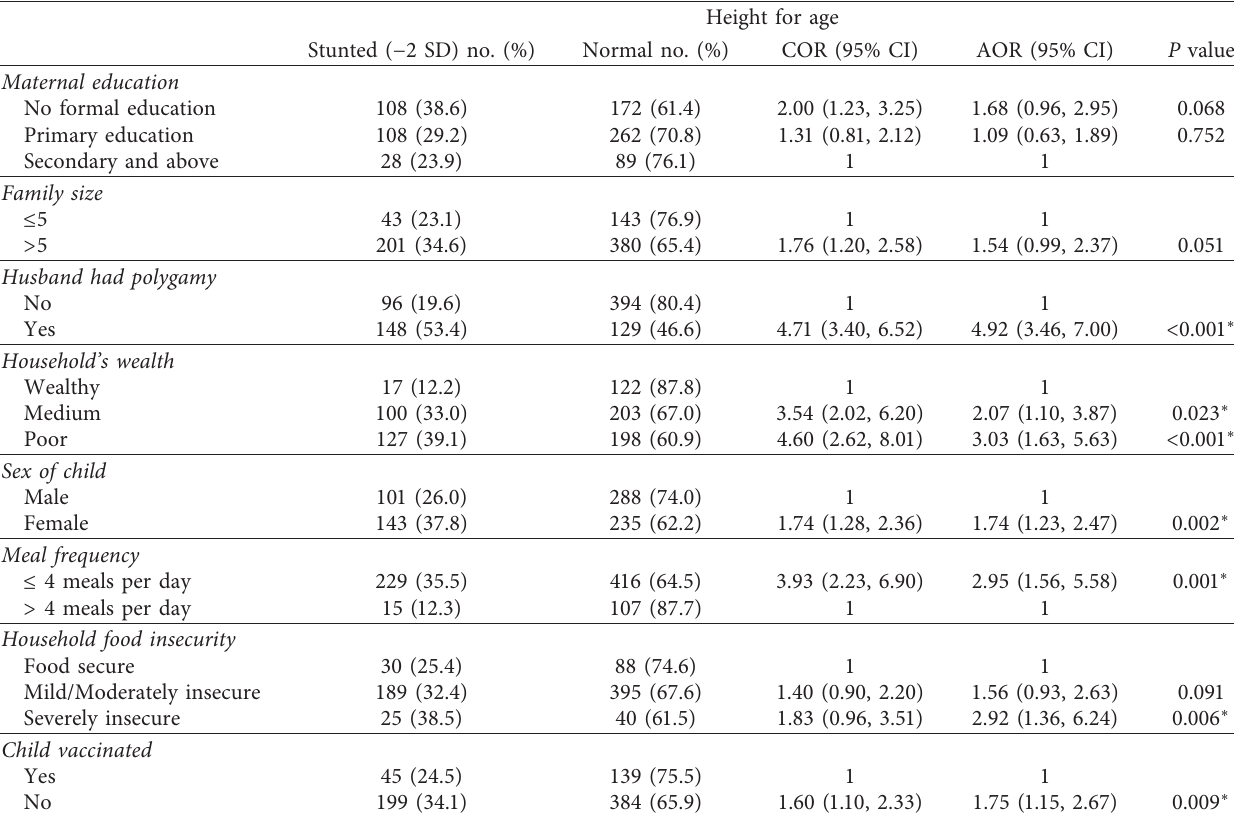
Table 2: Bivariable and multivariable logistic regression analyses for stunting among under-five-age children in West Guji Zone, Oromia, Ethiopia,